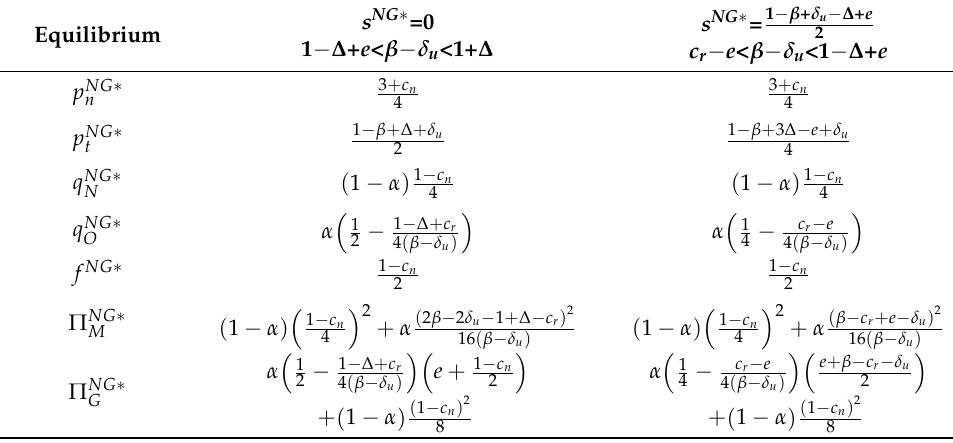
Table 5. Equilibrium optimal solutions and optimal profits under Model NG.